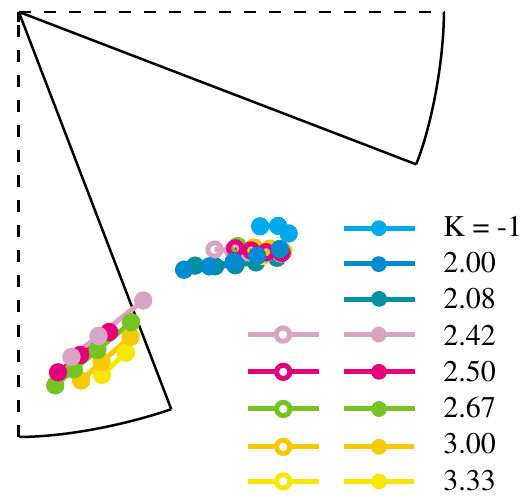
FIG. 5. (Color) Stripping foil area. The foil placements that bring the beams into the optimal exit point are shown. The foil positions that provide the best obtainable beam quality are marked with solid symbols. For those K ’s for which the optimal foil positions fall over the sector, the available backup positions in the valley are marked with open symbols. For K (cid:4) 2 : 5 and K (cid:4) 2 : 42 the optimal foil positions corresponding to had to be disregarded, since the the largest values of R m corresponding beam loops after the foil pass through the acceleration